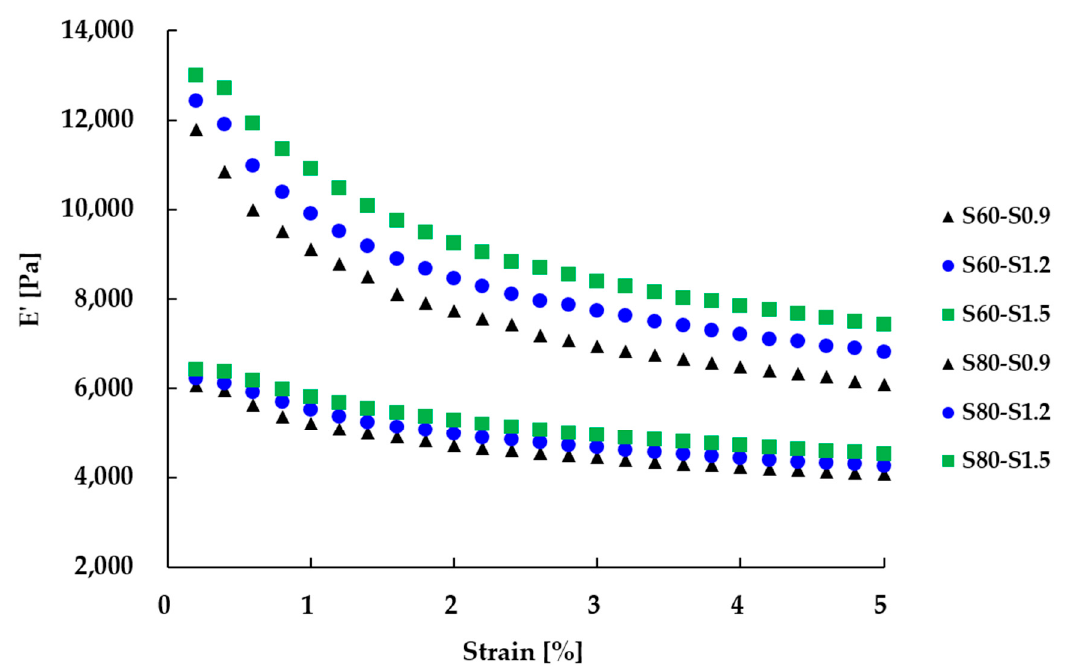
Figure 4. Storage modulus ( E ’) under different strain conditions at 60 ℃ .